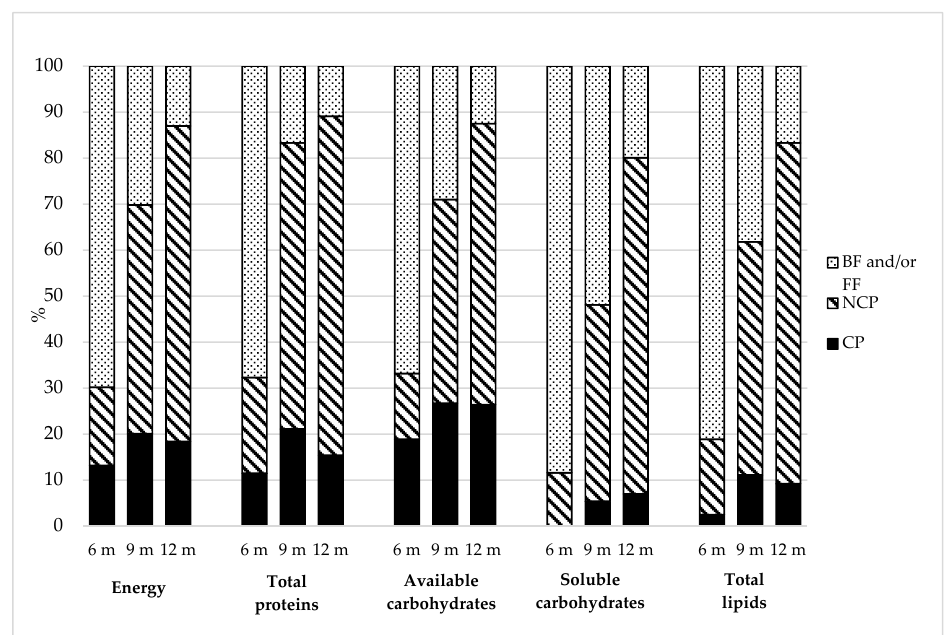
Figure 1. Contribution of different food types in terms of energy and macronutrients intake.